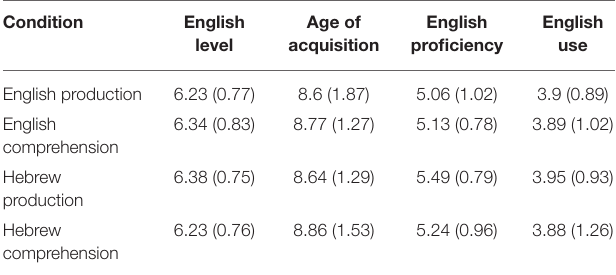
TABLE 1 | Participant characteristics in the different